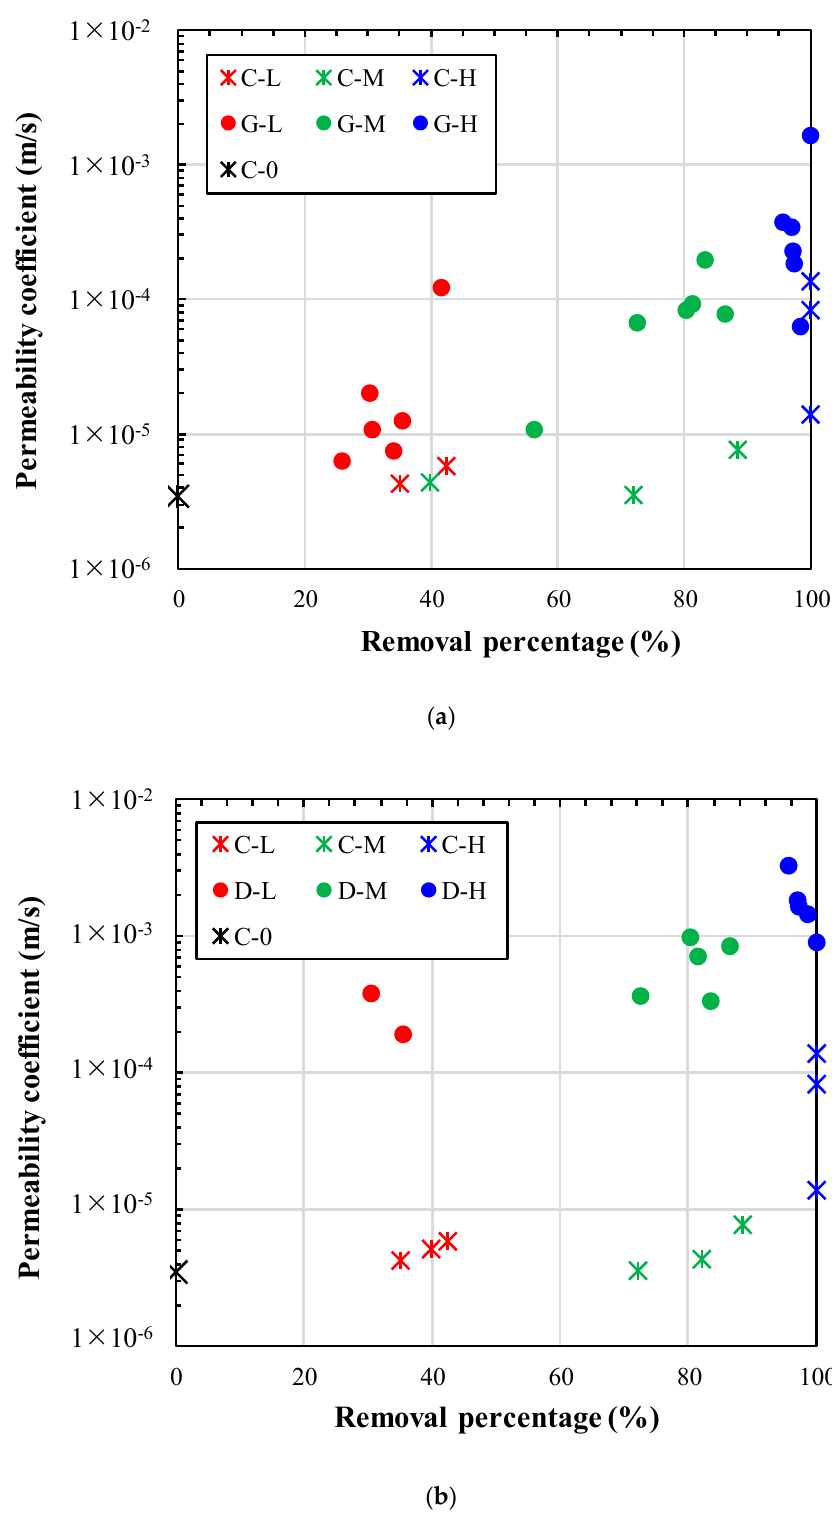
Figure 6. Relationship between pollutant removal percentage and permeability. ( a ) Gasoline; ( b ) Diesel. Note: C: original soil; G: soil with gasoline pollutant; D: soil with diesel pollutant. L: heating temperature is 320 °C; M: heating temperature is 560 °C; H: heating temperature is 900 °C.